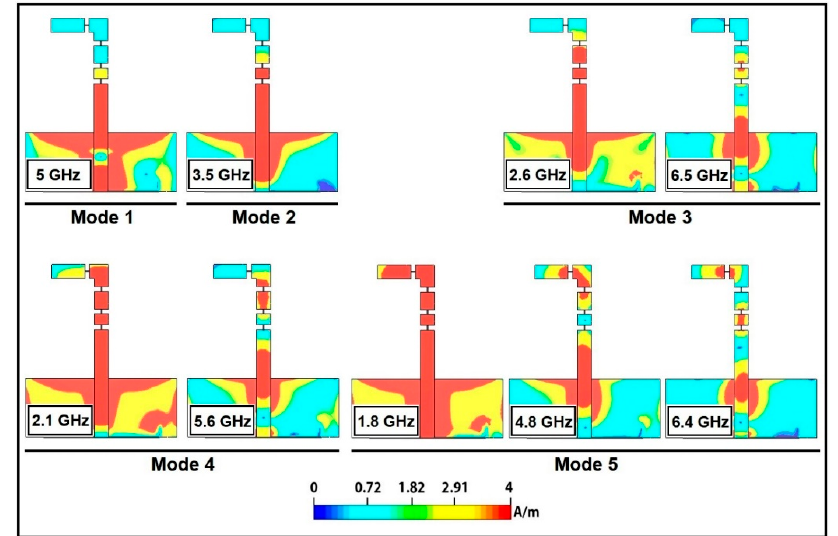
Figure 12. Surface currents plots of antenna at various modes. Table 4. Summary of the antenna’s performance.